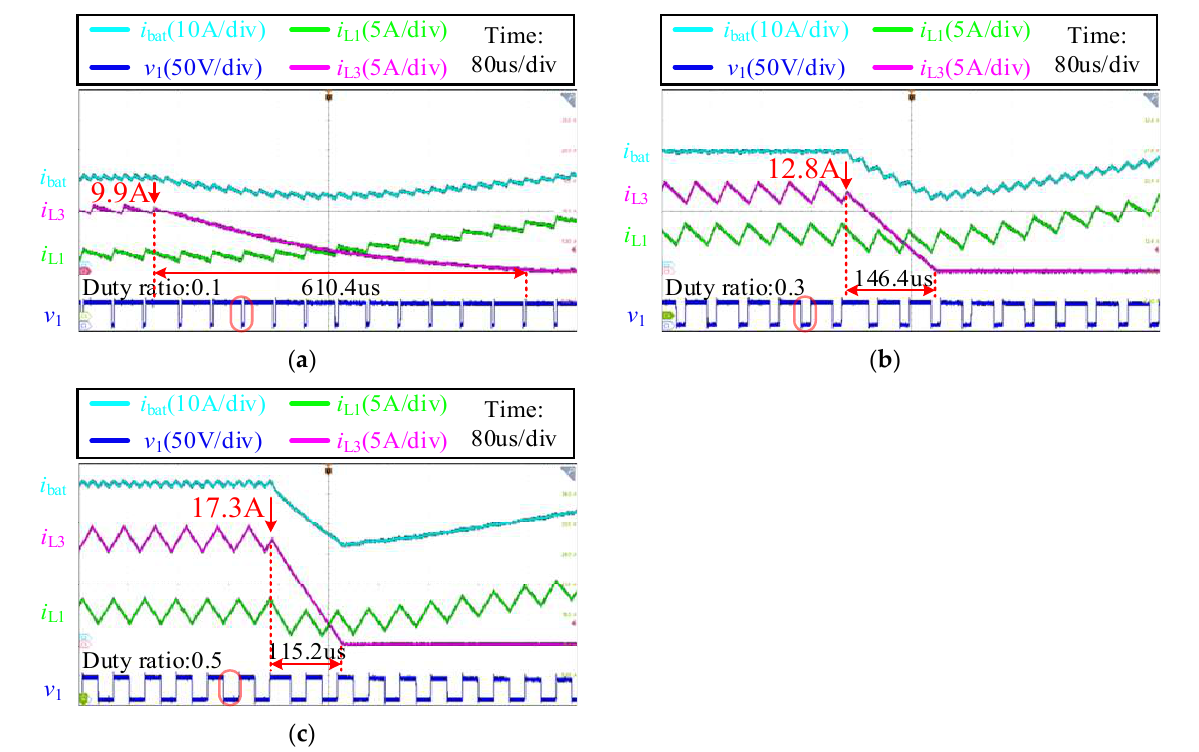
Figure 9. Total current i bat , normal phase current i L1 , and faulty phase current i L3 when OCF happens under different conditions of duty ratio: ( a ) D = 0.1; ( b ) D = 0.3; and ( c ) D = 0.5. Table 4. Parameters of 3-phase coupled buck–boost converter.